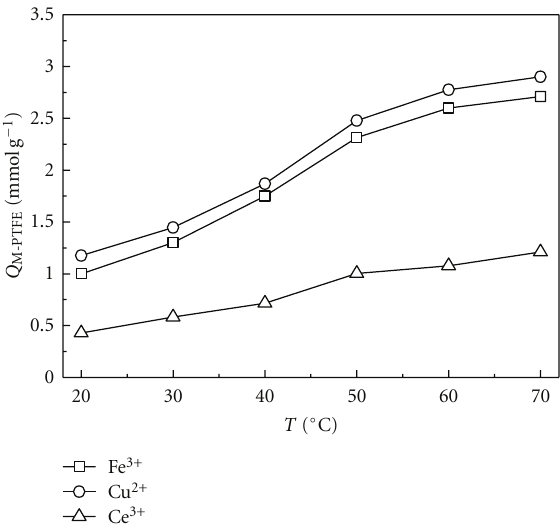
Figure 4: Q M-PTFE of the complexes at di ff erent reaction tempera-